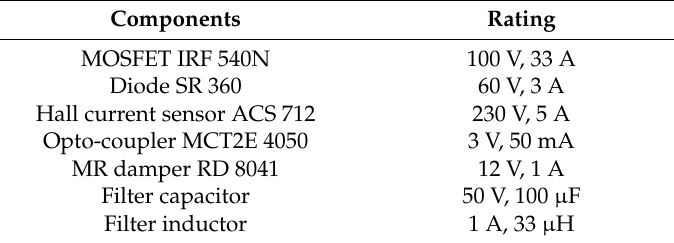
Table 2. Details of the embedded system components.